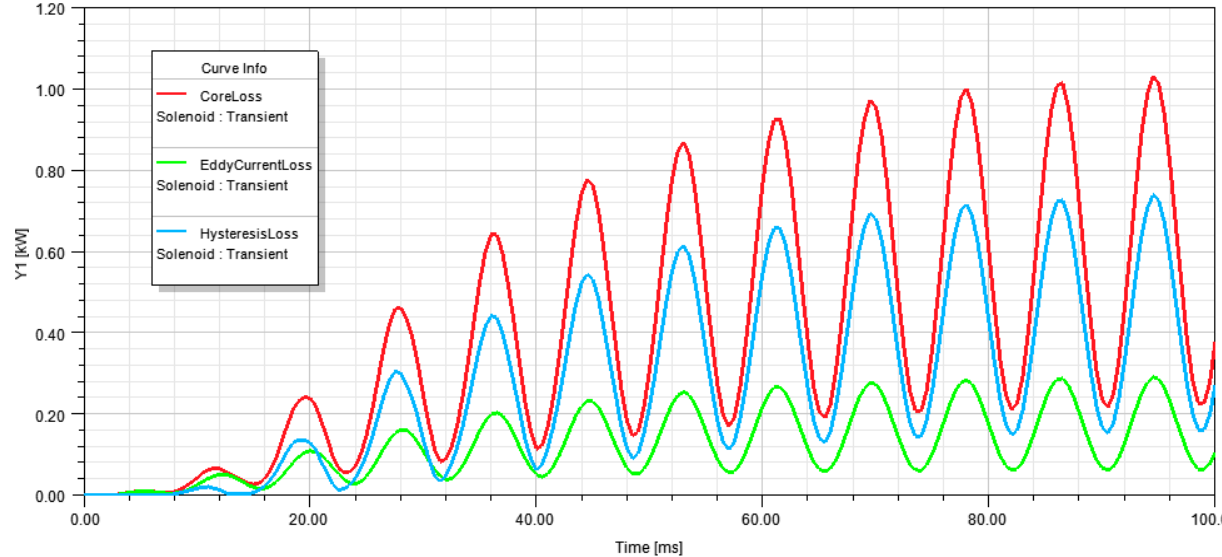
Figure 9. Flux density simulation of harmonic profile design transformer: ( a ) core; ( b ) tank. As shown in Figure 10, the total losses (CoreLoss), eddy current losses, and hysteresis losses are calculated. The total loss calculation had a maximum value of 1.12 kW.